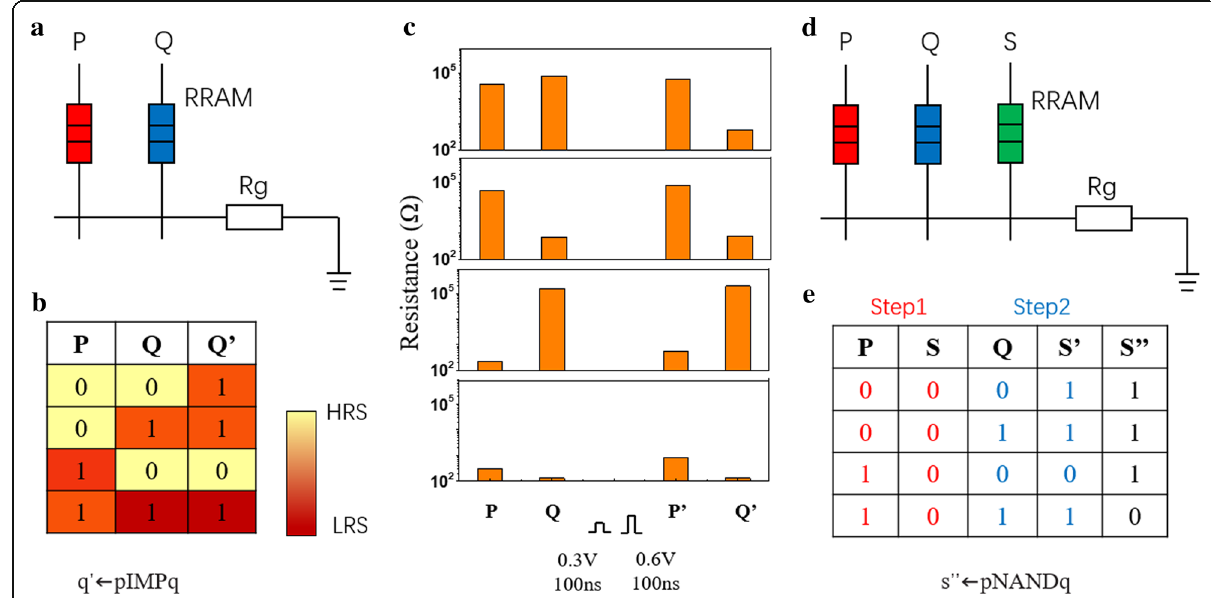
Fig. 5 The test diagram of IMP ( a ) and NAND ( d ) logic. b The truth table for the operation q ← pIMPq ( c ) and q ← pNANDq ( e ). The state changes of P and Q with pulse ( c